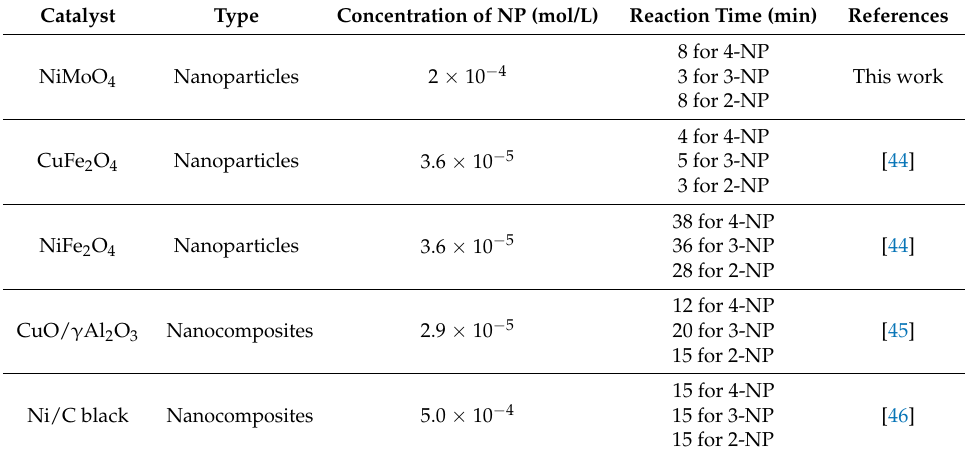
Table 1. A comparison of reaction time for the reduction of 2-NP 3-NP and 4-Np by NiMoO 4 with other nanocatalysts reported in the literature.